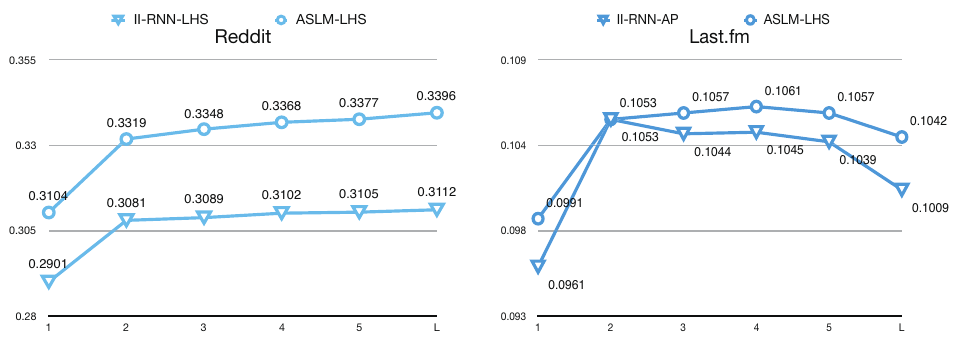
Figure 1. Comparison of cold-start effects at the start of a new session for Reddit and Last.fm datasets between ASLM and II-RNN.